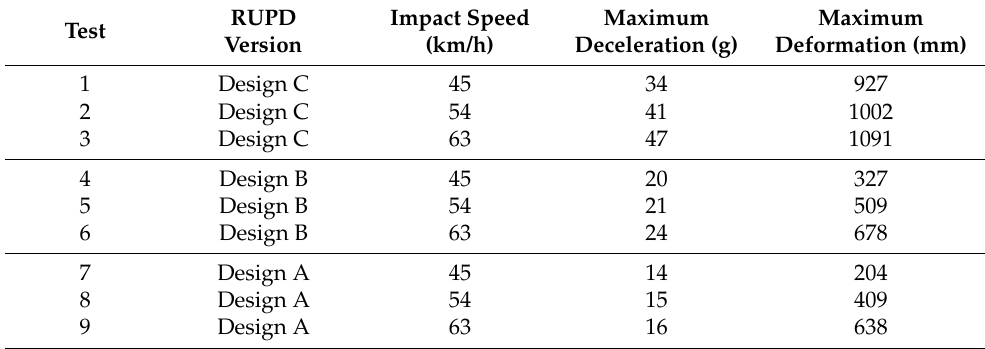
Table 5. Results of measurements of car deceleration and RUPD deformation, for 3 RUPD versions and various impact